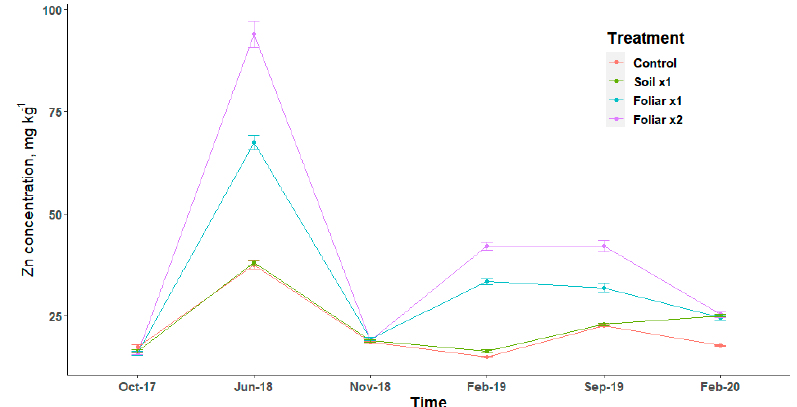
Figure 3. Leaf Zn concentration at six sampling dates by treatments with standard error bars (n = 9). Treatments: control—standard soil Zn applied; foliar x1—standard soil Zn applied + foliar-applied Zn based at 1 × UF / IFAS recommendations; foliar x2—2 × foliar-applied Zn at UF / IFAS recommendations + standard soil Zn application; soil x1—2 × soil-applied UF / IFAS recommendations (5.60 kg Zn ha − 1 ).